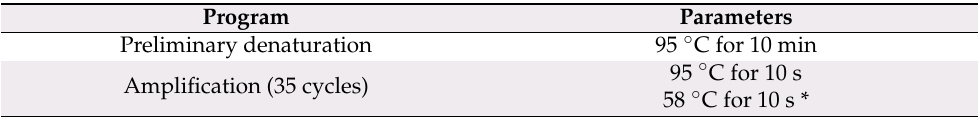
Table 3. Conditions of the qPCR analysis for the NIb ORF